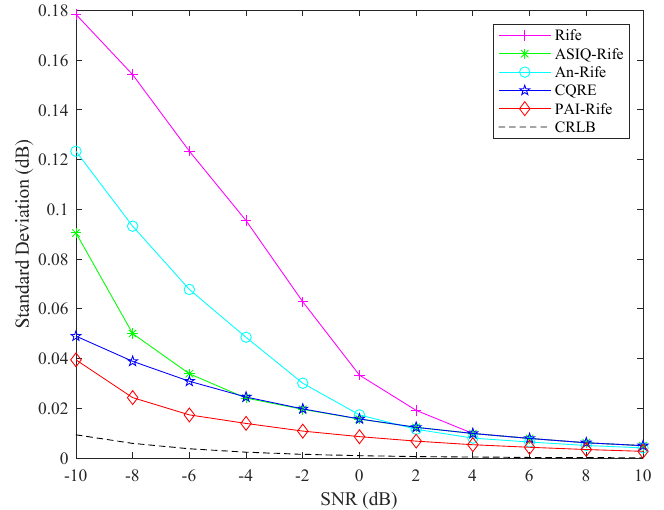
Figure 7. Standard deviation of PAI − Rife and other Rife algorithms at different SNRs.